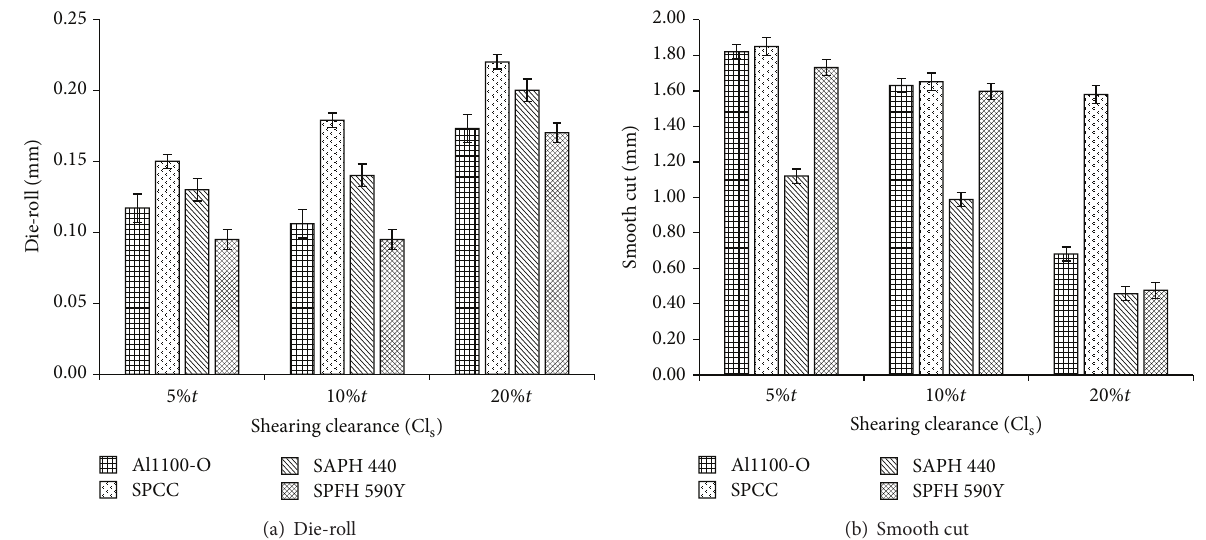
Figure 5: Relationship between shaved surface features and shearing clearances ( 𝐷 sh : 0.1 mm).